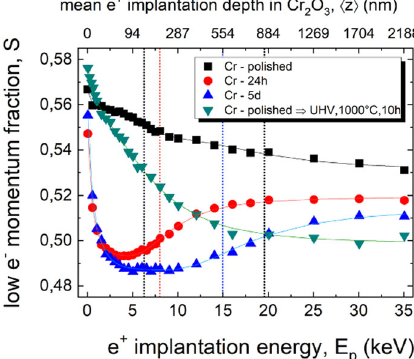
Fig. 4 DB-VEPAS results for annealed and as-polished chromium versus thermally oxidized chromium. S-parameter for a reference UHV 1000 °C, 10 h annealed Cr, as-polished Cr, and Cr oxides annealed to both 24 h and 5 d from DB-VEPAS. The curves are fi tted using the VEP fi t code 44 and vertical lines represent interfaces between speci fi c regions of different open volume (Cr - polished sample) or between the oxide and Cr (oxidized samples).